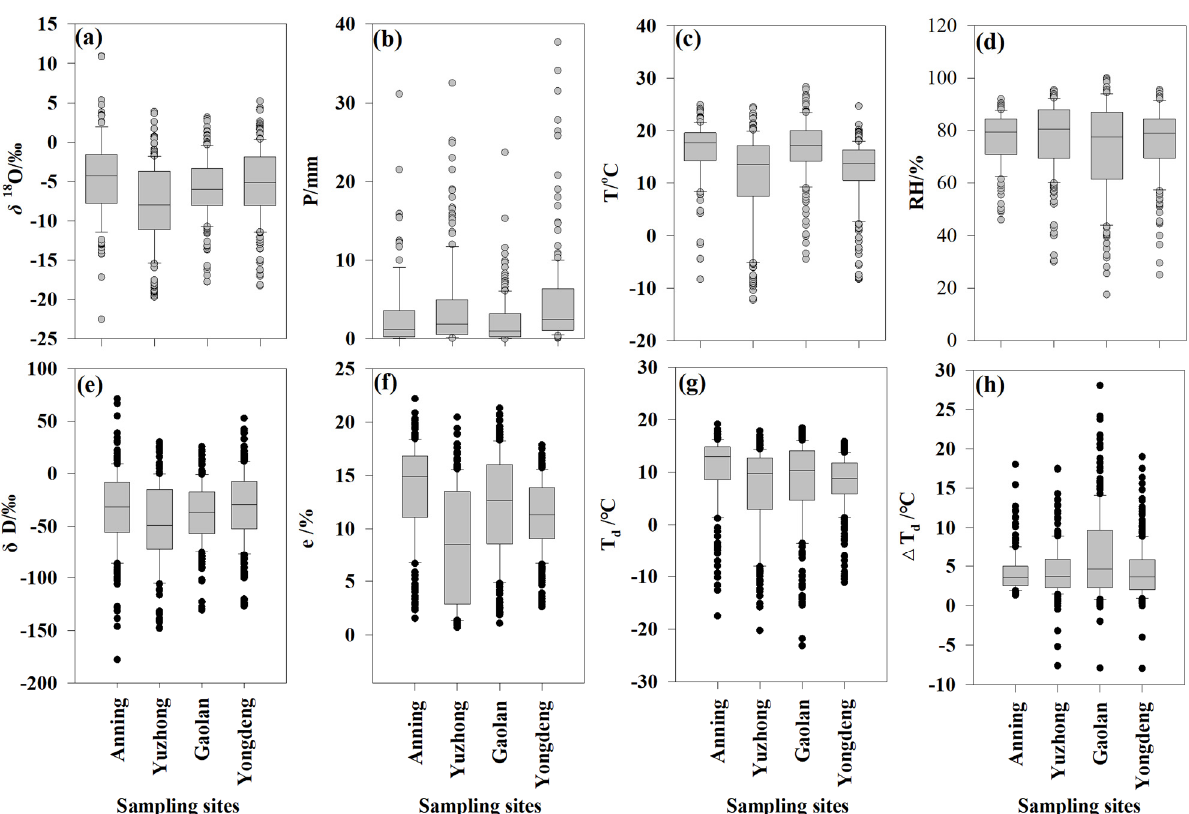
Figure 8. The variations of oxygen isotopic ratio ( a ), hydrogen isotopic ratio ( e ), and meteorological elements ( b – d , f – h ) ( P -precipitation amount, T -air temperature, RH -relative humidity, e -water vapor pressure, T d -dew point temperature, and Δ T d -depression of dew point) for each sampling station in Lanzhou from 2011 to 2014. For the box plots, the bottom of the box indicates the 25th percentile, a line within the box marks the median, and the top of the box indicates the 75th percentile; whiskers indicate the 90th and 10th percentiles; points above and below the whiskers show the outliers.